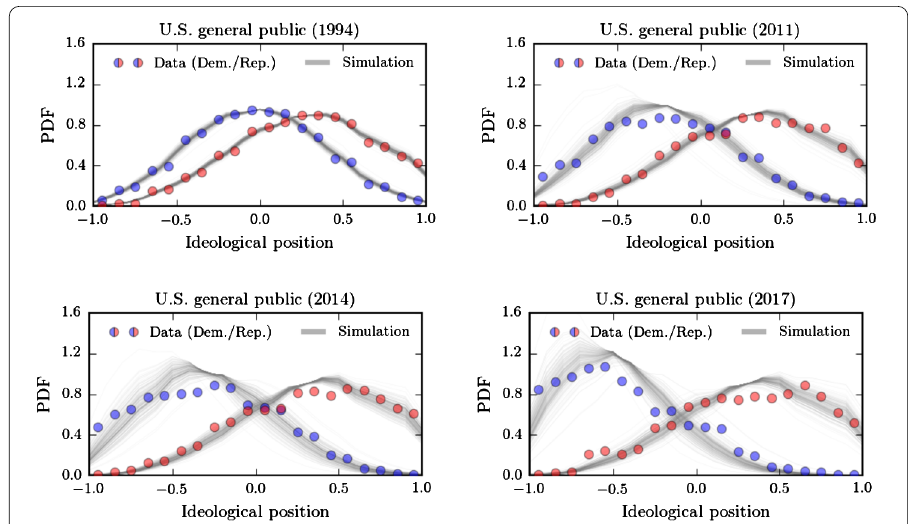
Figure 4 Polarization in the U.S. general public in comparison with our model. For the U.S. general public, we show the ideology distributions for Democrats (blue disks) and Republicans (red disks). The dataset is based on a survey conducted by Pew Research Center (see [6] for details). We initialized our model (grey solid lines) with the data of 1994 and only modified the distributions according to a transition probability rescaling as described by Eqs. (10) and (11)